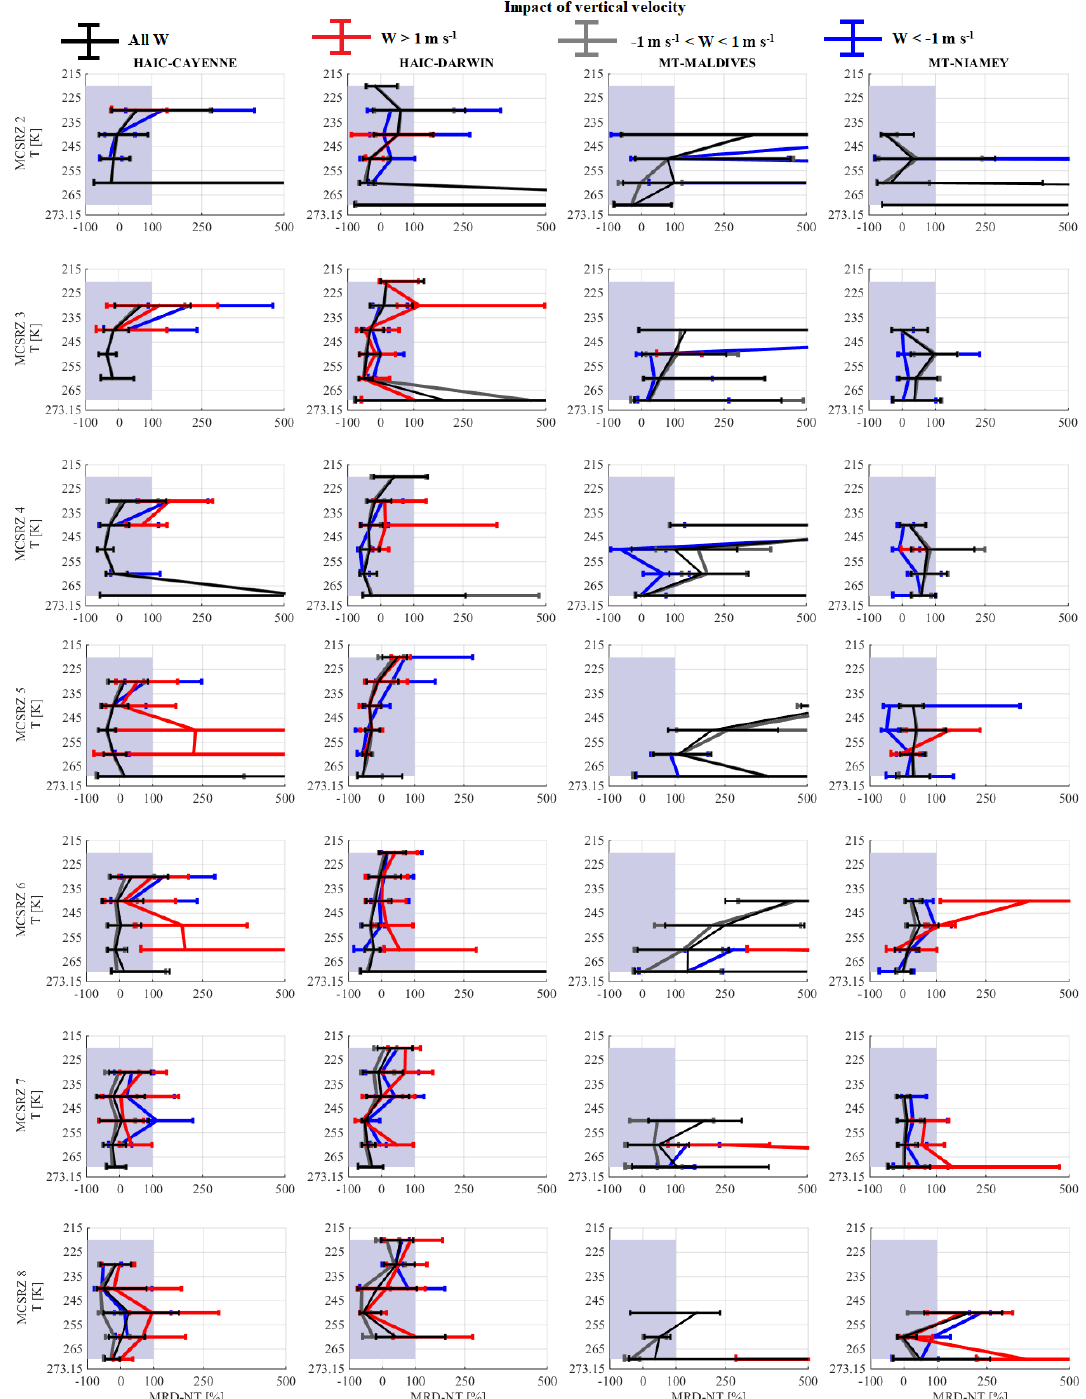
Figure B2. Median relative difference of total concentration of hydrometeors (MRD-NT) in regard to median total concentrations calculated for the merged dataset in each MCS reflectivity zone (Fig. A1). Results are sorted as a function of MCSRZ 2 (top line) to MCSRZ 8 (bottom line). The blue lines represent MRD-NT for vertical velocity smaller than − 1ms − 1 . The grey lines represent MRD-NT for vertical velocity larger than − 1ms − 1 and smaller than 1ms − 1 . The red lines represent MRD-NT for vertical velocity larger 1ms − 1 . The black lines represent MRD-NT when there is no distinction as a function of vertical velocity (as in Fig.